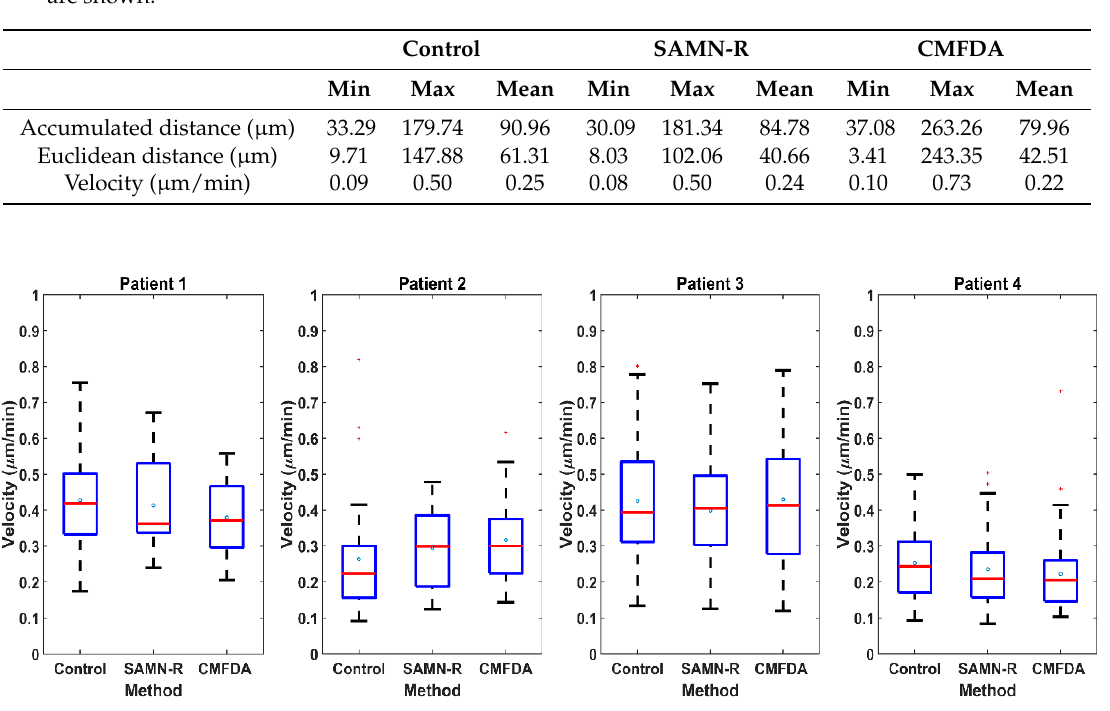
Figure 9. Tracks of hMSCs. ( A ) Non-labelled cells (control); ( B ) SAMN-R treated cells; ( C ) CMFDA- labelled cells. The blue circle is a detected cell, the blue line is accumulated distance, and the yellow line is Euclidean distance. Confocal microscopy, 10× magnification, scale bar 250 µm. 3. Discussion Fibroblasts and mesenchymal stem cells have prominent status in the hierarchy of mammal cells. Fibroblasts are one of the most populous and important cells of connective tissue, and play the crucial role in normal pre- and postnatal organ development. They represent key components for wound healing and the occurrence of tumors. MSCs are relatively more latent cells in normal development; however, their effective migration, proliferation, and interaction with other cell types are essential in the critical time after tissue scarring or ischemic events, when wound healing and correction of abnormal immune reactions begins. Unfortunately, fibroblasts and MSCs could be negatively affected by modern cell markers, cell labels, or labelling nanoparticles [22,23]. The negative effect of markers and nanoparticles may occur a short time after their application. Such markers and nanoparticles with acute toxicity cause visible rapid morphological changes and cells rapidly die. Markers and nanoparticles, that can be seemingly non-toxic, may have a hidden long-term negative effect that can manifest after several days. Moreover, the effect need not necessarily lead to apoptosis of the cell, but rather to the abnormal production of certain factors in the cell (e.g., reactive oxygen) or to altered metabolism or cell motility.